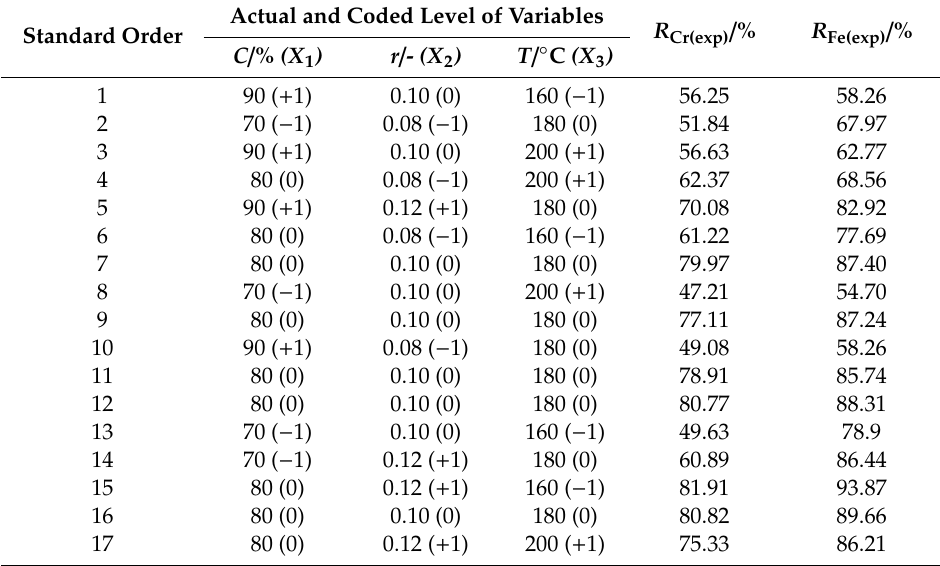
Table 2. Box–Behnken design (BBD) with actual and coded values (in parentheses) for variables and experimental